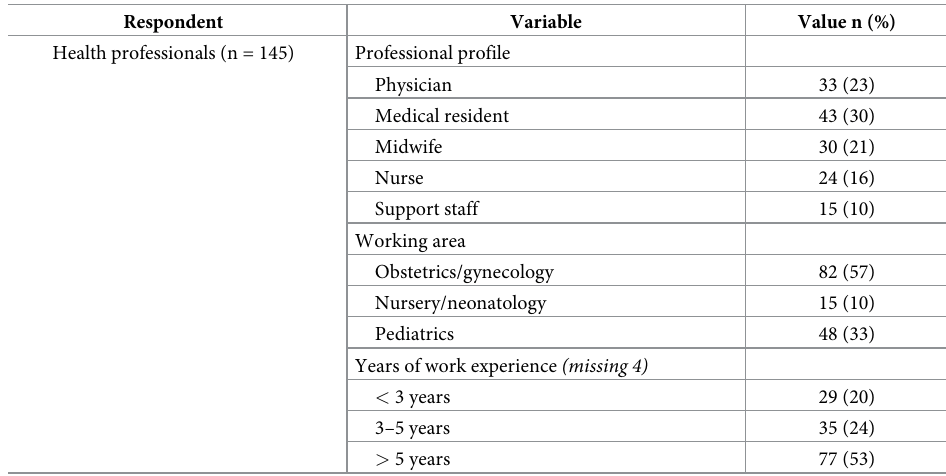
Table 1. Socio-demographic characteristics of survey